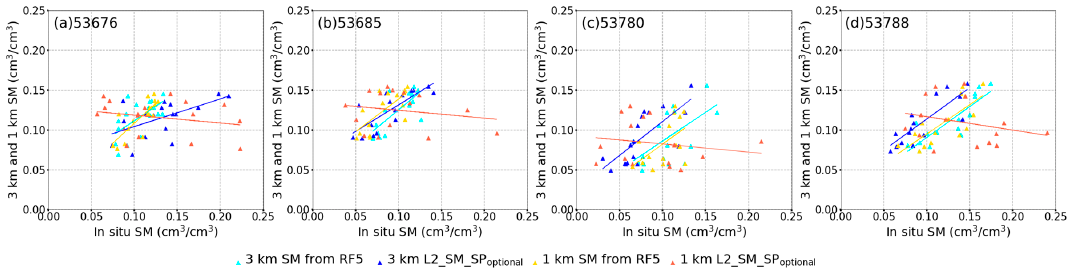
Figure 8. Scatterplots of SM estimates from RF5 and L2_SM_SP optional product (3 km and 1 km) vs. in situ SM at the four SM stations. Table 5. Results comparison summary of the overlapping observations of L2_SM_SP optional and SM